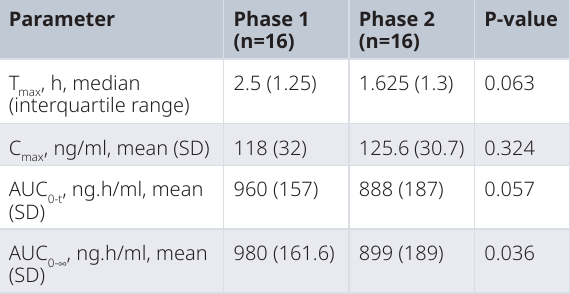
Table 3. Pharmacokinetics findings of empagliflozin 10 mg.